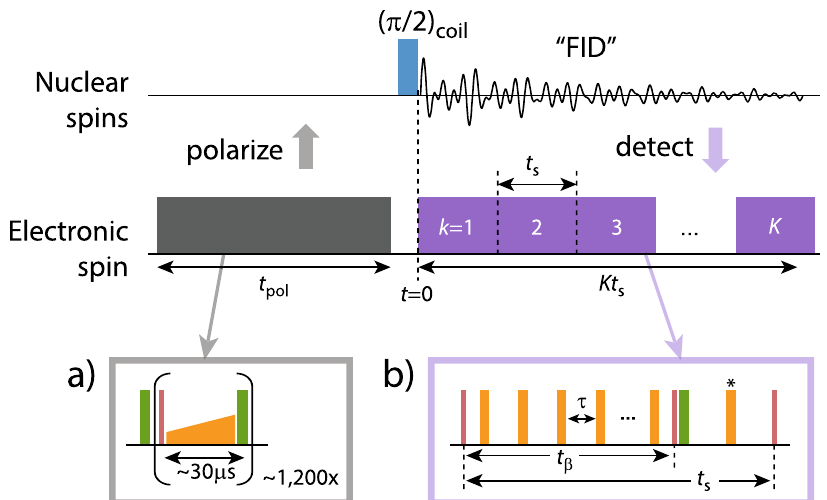
Fig. 2 Weak-measurement protocol for detecting the free precession signal from many nuclei in parallel. We polarize the nuclear spins by a repeated NOVEL sequence (gray, inset a ) 87,88 , initiate simultaneous precession of all nuclei by applying a π /2 pulse with an external RF coil (blue) 62 , and detect the precession by repeated sampling of the transverse nuclear magnetization (purple) 17,18,89 . t pol is the polarization time, t s is the sampling time and K is the number of samples. Each weak-measurement read-out block (inset b ) consists of a Carr – Purcell – Meiboom – Gill (CPMG) pulse train 90 – 92 of 4 − 24 equidistant π pulses (orange) separated by a delay time τ = 1/(2 γ n B 0 ), followed by an optical read-out pulse (green). Red blocks are π /2 pulses. The duration of the CPMG sequence de fi nes the interaction time t β . An additional π pulse (*) is used to average over the electronic m S = 0, − 1 states. See the Supplementary Information for the full-timing diagram and experimental